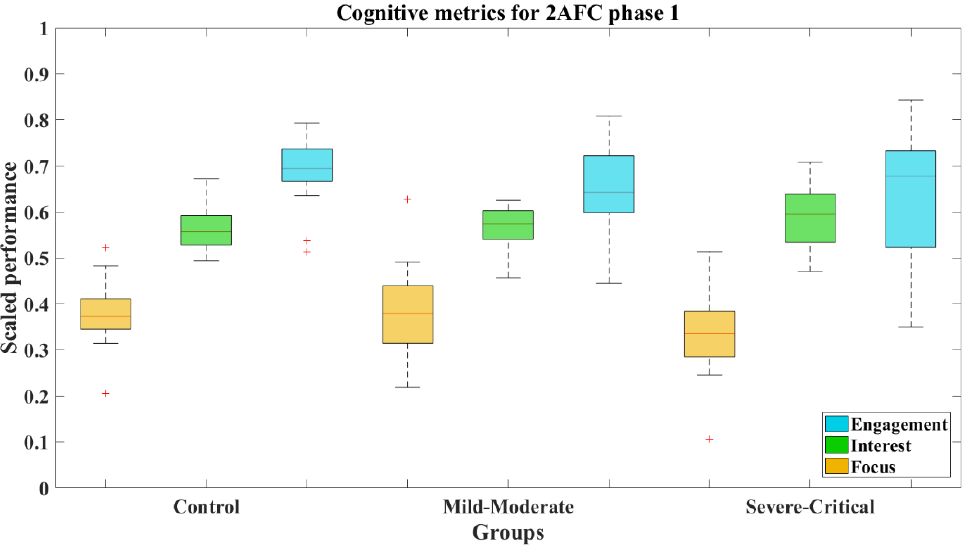
Figure 8. Cognitive metrics for 2AFC-P1 by group. Red line—median value of Focus, Interest, and Engagement for the corresponding group; red plus sign (+)—Outliers for the corresponding performance metric.